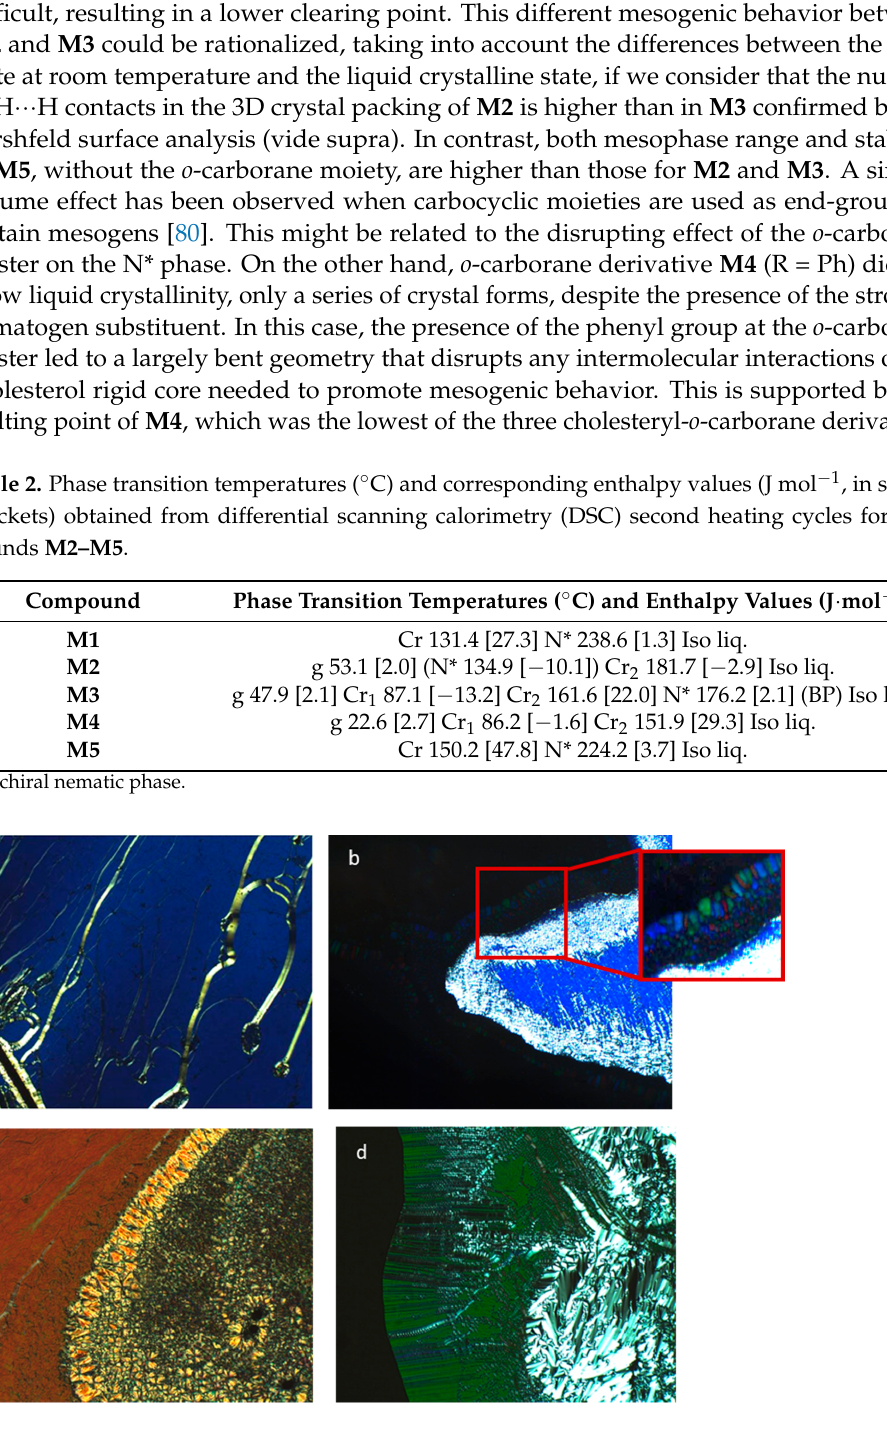
Figure 5. ( a ) Optical texture of M3 in the N* phase at 162.2 °C. ( b ) Polarized optical microscopy (POM) image of the blue phase of M3 . ( c ) POM image of M2 at 119.0 °C on cooling from the isotropic liquid, showing the N* and crystal phases. ( d ) POM image of M5 at 186.2 °C during the cooling cycle showing the N* phase. Table 2. Phase transition temperatures (°C) and corresponding enthalpy values (J mol − 1 , in square brackets) obtained from differential scanning calorimetry (DSC) second heating cycles for com- pounds M2–M5 .